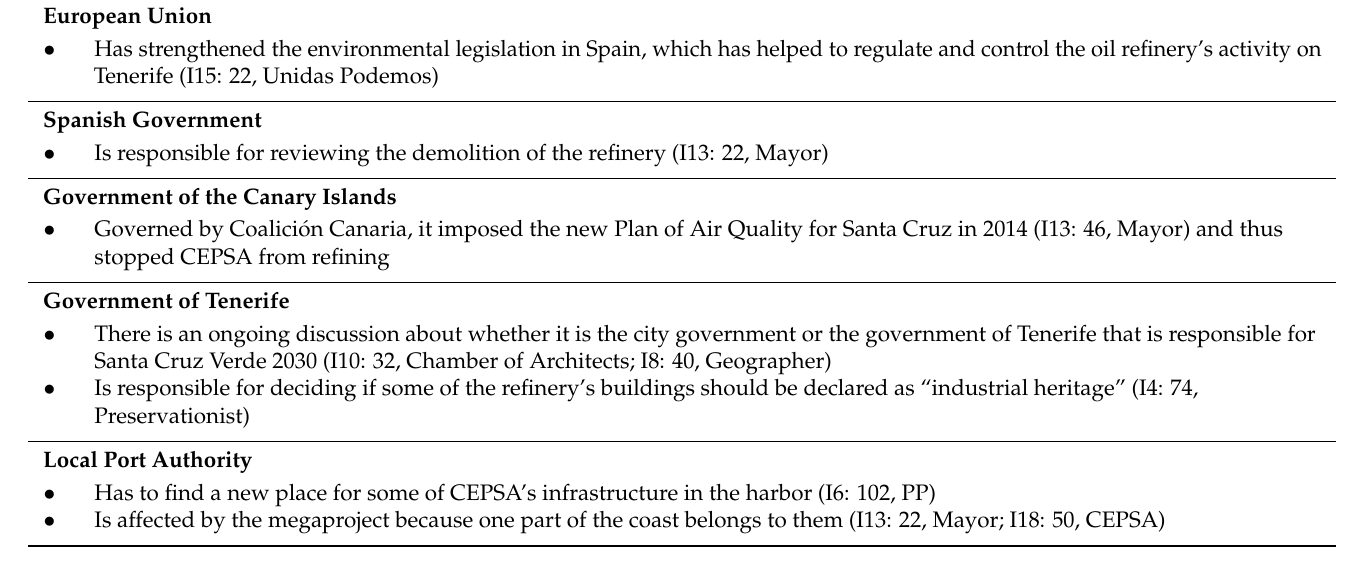
Table 3. Governmental